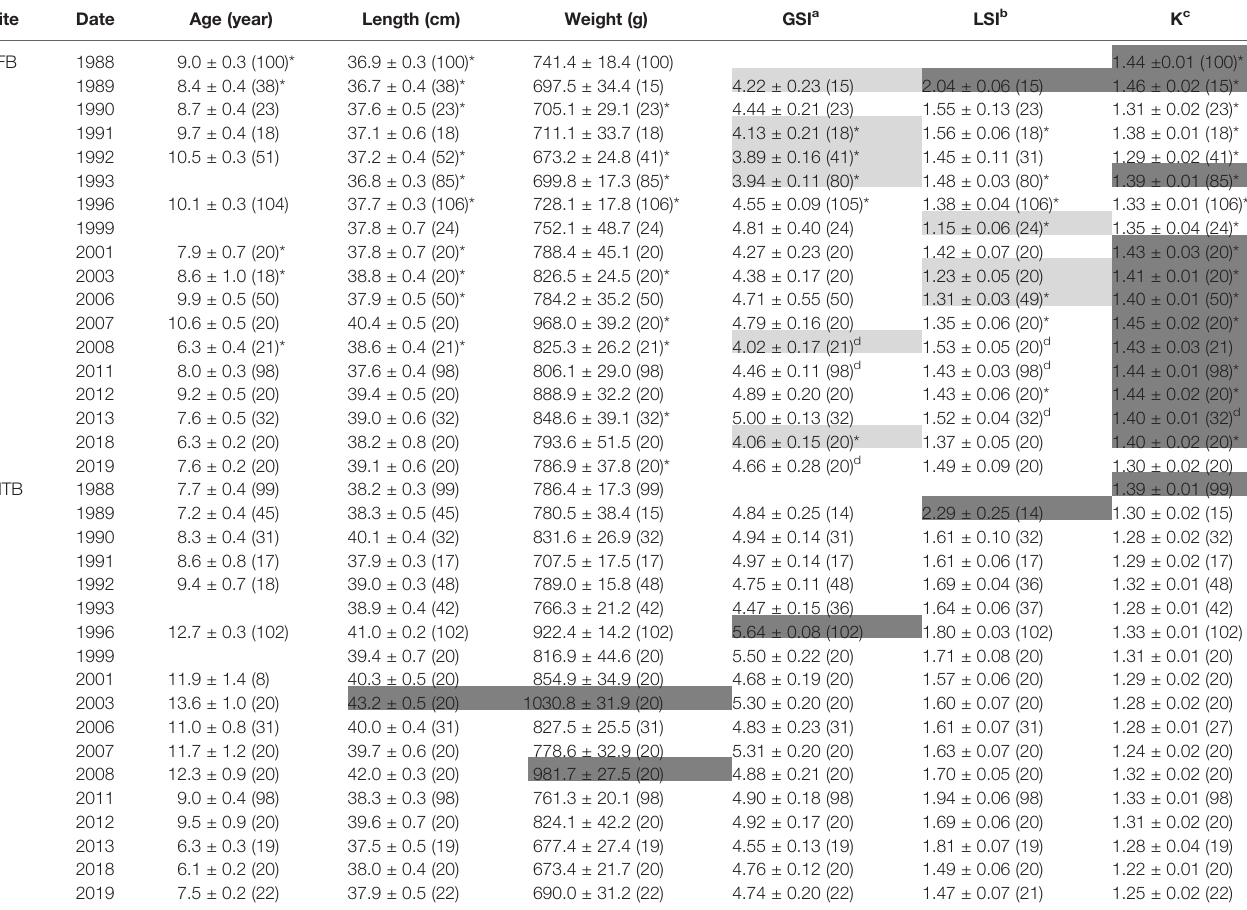
Values are reported as mean ± SE (n). Shaded cells are either below (light grey) or above (dark grey) normal range for Mountain Bay. *Signi fi cant difference between sites (p ≤ 0.05) within years; a GSI = 100* (gonad weight/body weight); b LSI = 100* (liver weight/body weight); c K = 100*(weight/length 3 ); d Represents an interaction between sites; All data before 2008 published in Bowron et al.